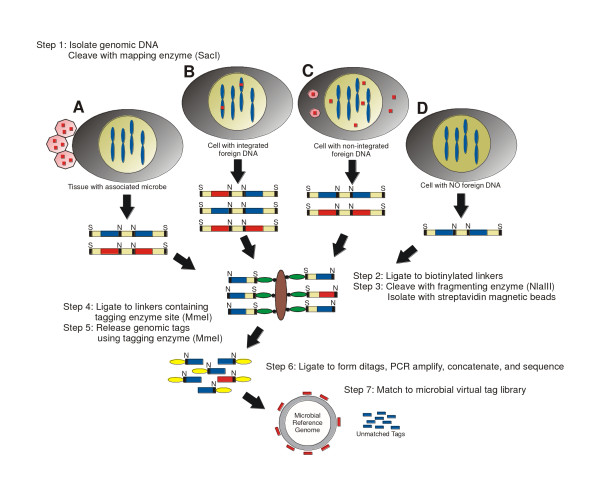
Schematic of DK-MICROBE. Tissue of interest may have four potential microbial association states: (A) human cells associated with surrounding microbes, (B) human cells with integrated foreign DNA, (C) human cells with non-integrated foreign DNA, and (D) human cells with no foreign DNA. Sequential restriction digests by SacI (restriction sites indicated by "S") and NlaIII (indicated by "N") result in sequence tags derived from foreign DNA sequences (red boxes), and human sequences (blue boxes). Small ovals represent linkers while large brown ovals represent streptavidin-coated magnetic beads. Experimental tags are matched to microbial virtual tag library, representing all known microbial reference genomes. Unmatched tags include human sequences.